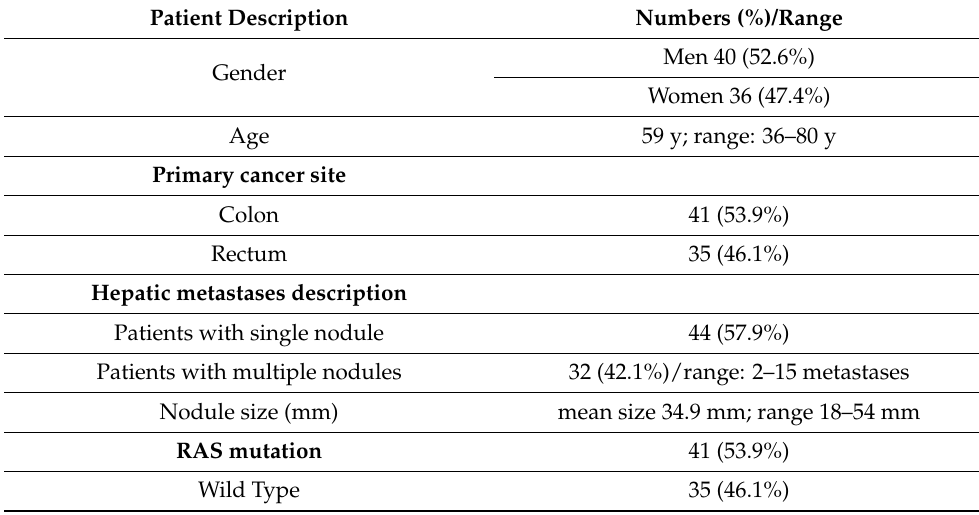
Table 1. Characteristics of the study population.